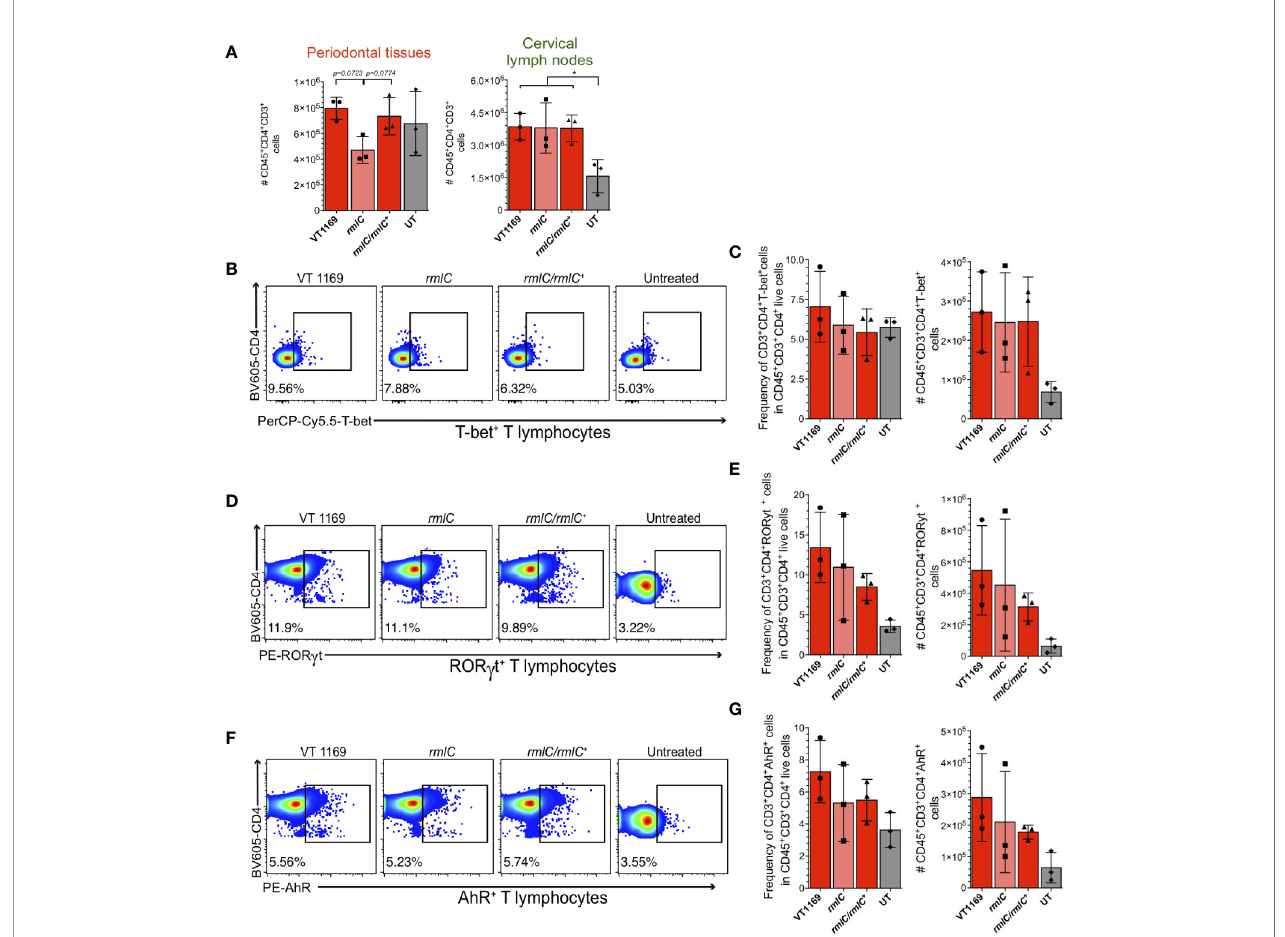
FIGURE 4 | T-bet + , ROR g t + , and AhR + T lymphocytes detection within the cervical lymph nodes induced by the different strains of A. actinomycetemcomitans . Cells obtained from cervical lymph nodes were analyzed by fl ow cytometry. (A) Comparison of the number of single/live/CD45 + CD3 + CD4 + T lymphocytes between periodontal tissues and cervical lymph nodes. Flow cytometric quanti fi cation of (B , C) CD45 + CD3 + CD4 + T-bet + Th1 lymphocytes, (D , E) CD45 + CD3 + CD4 + ROR g t + Th17 lymphocytes, and (F , G) CD45 + CD3 + CD4 + AhR + Th22 lymphocytes in periodontal lesions upon infection with the A. actinomycetemcomitans VT1169, rmlC , or rmlC/rmlC + strains, or the untreated (UT) controls. Data were pooled from three independent experiments (n=3). Mean ± SD, one-way ANOVA and Holm-Sidak post- hoc test, *p < 0.05. Error bars represent SEM in all